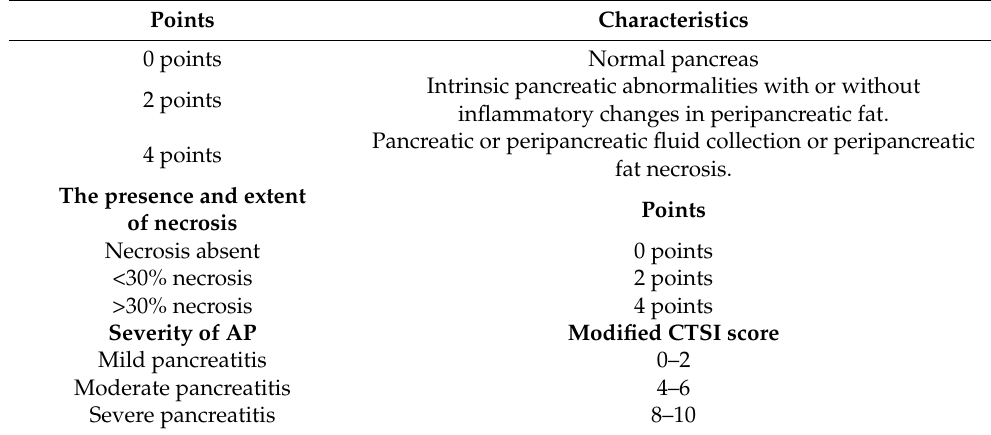
Table 5. Modified Mortele CTSI